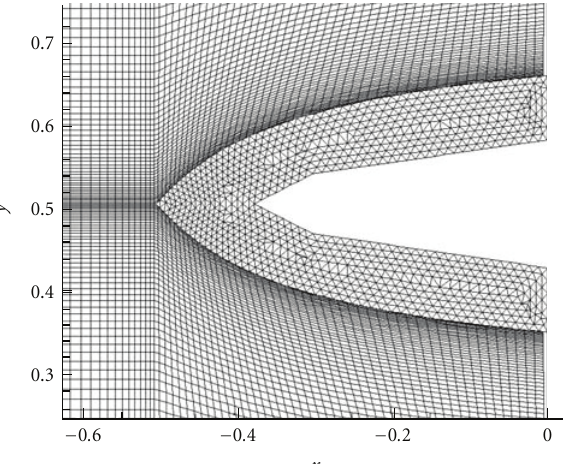
Figure 3: Fluid domain and structure shell meshes used for the simulations of the hollow cone